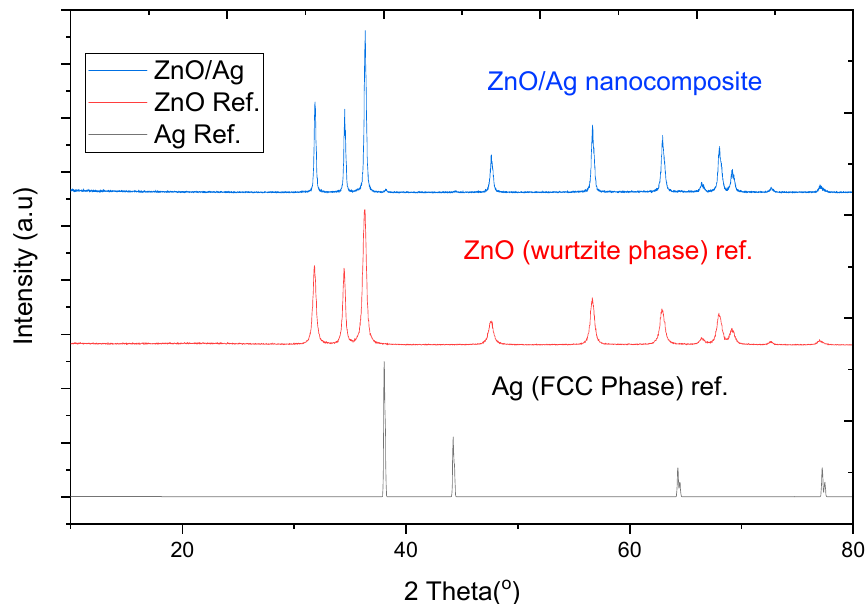
Figure 3. XRD pattern of ZnO/Ag nanocomposite with correlation with the wurtzite phase of ZnO adapted from Ref. [23] and the face-centered cubic (FCC) phase of Ag, adapted from reference [20].